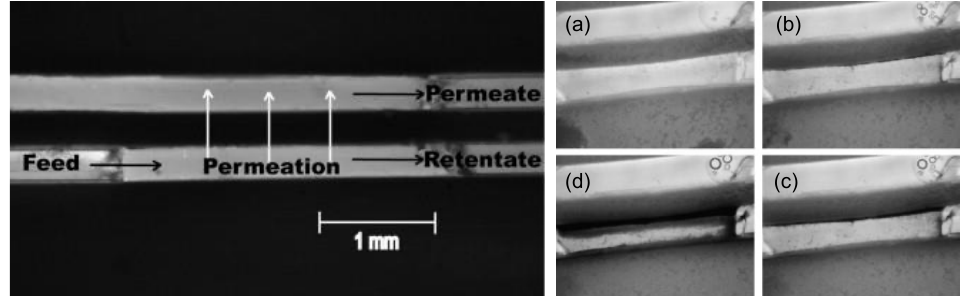
Figure 7. On the left, a microfluidic filtration device allowing side observation of the membrane developed by Ngene et al. Pictures on the right show the temporal evolution (from a – d ) of the cake layer, which can be clearly distinguished in ( d ). Adapted from [67].